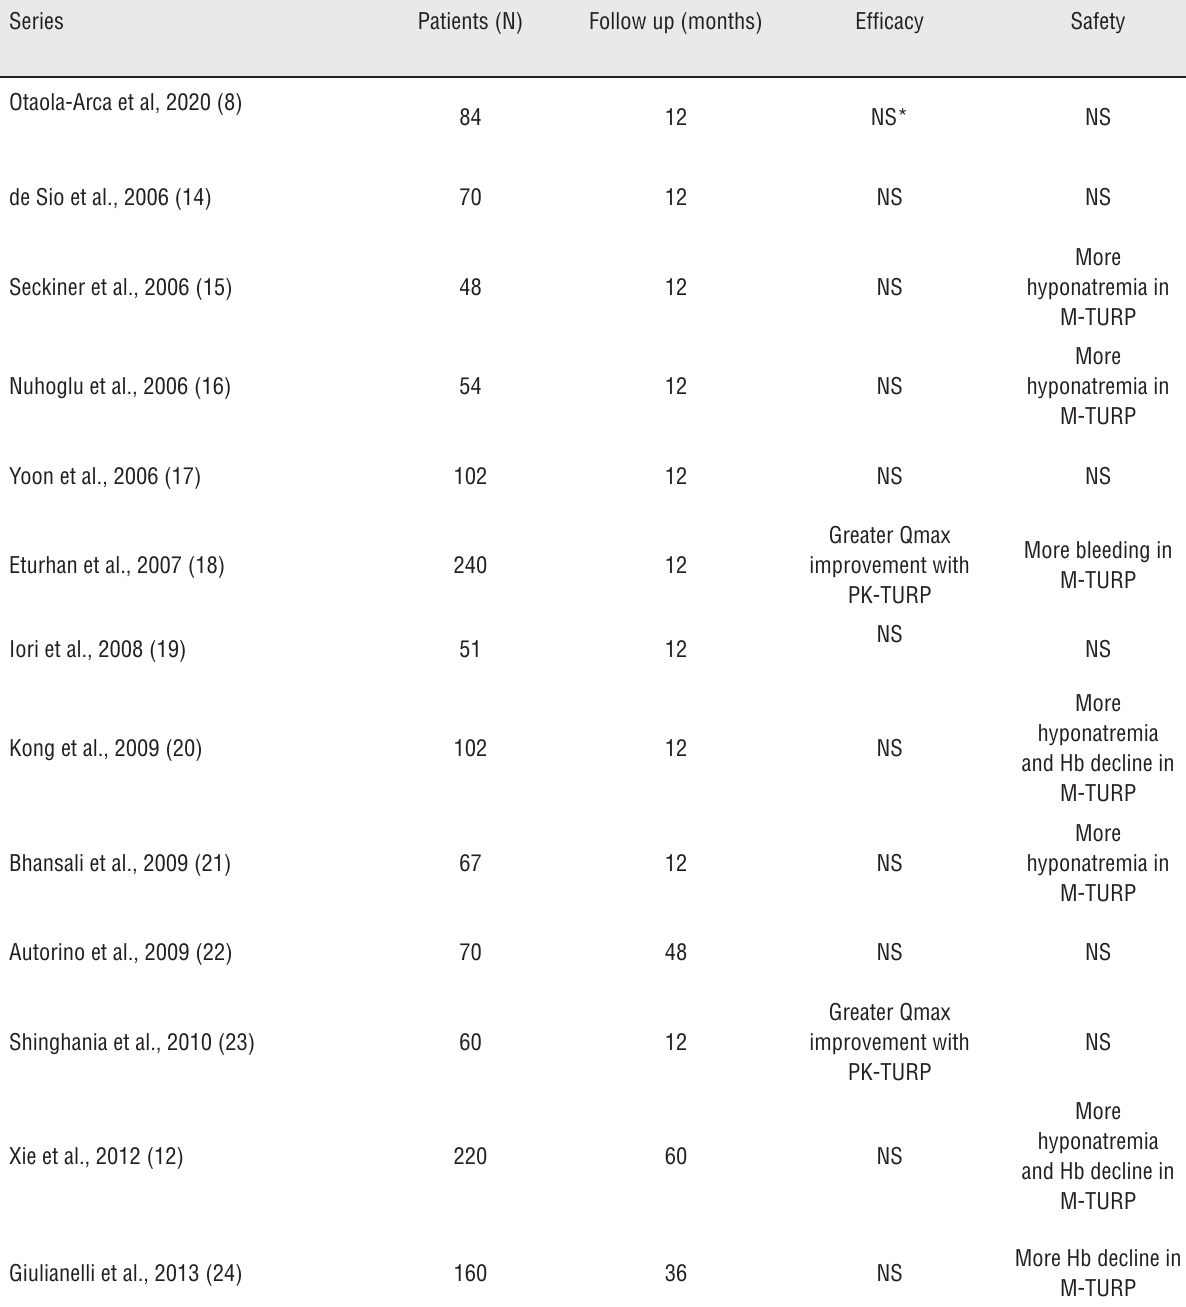
Table 1 - Efficacy and safety of PK-TURP vs M-TURP in